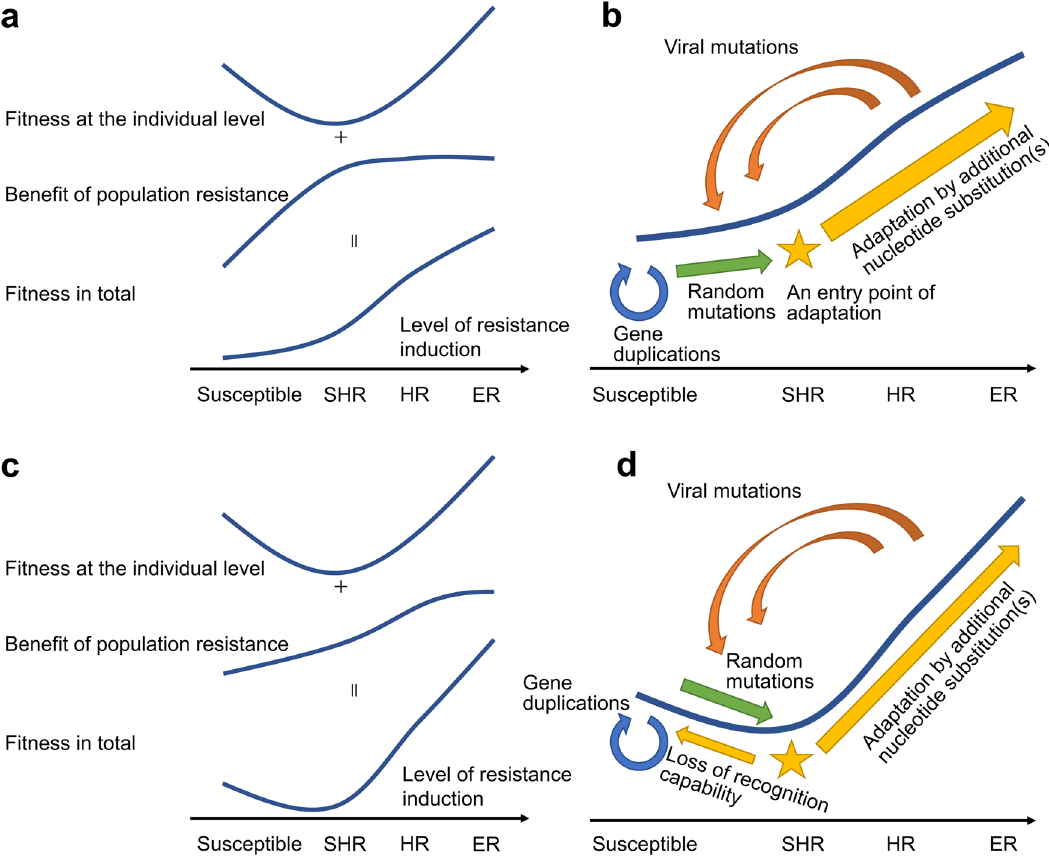
Fig. 7 Proposed evolutionary trajectory of antiviral R genes. Schematic representations for fi tness curves and evolutionary trajectories when the bene fi t of suicidal population resistance exceeds the cost of individual death ( a , b ) and does not ( c , d ). Fitness at the individual and population levels for full susceptibility and the induction of SHR, HR, and extreme resistance (ER) ( a , c ). Proposed trajectory of antiviral R gene evolution ( b , d ). Note that adaptation from SHR to full susceptibility will also occur in the latter